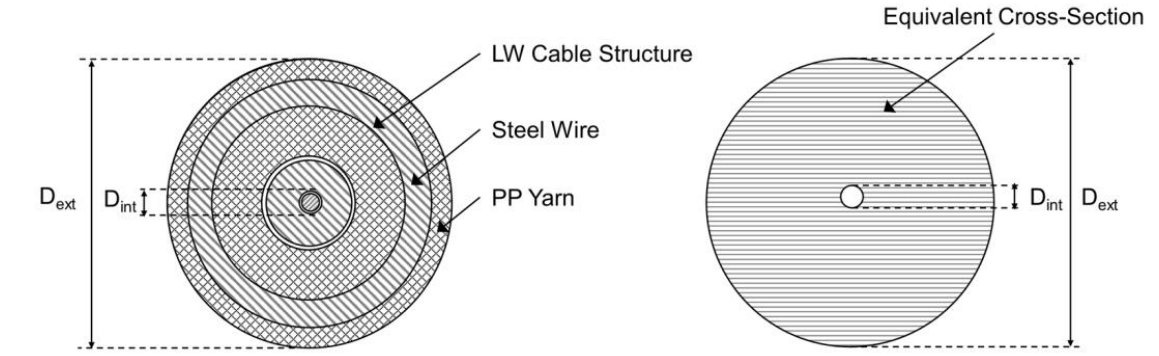
Figure 11. SA submarine cable and its equivalent cross-section.